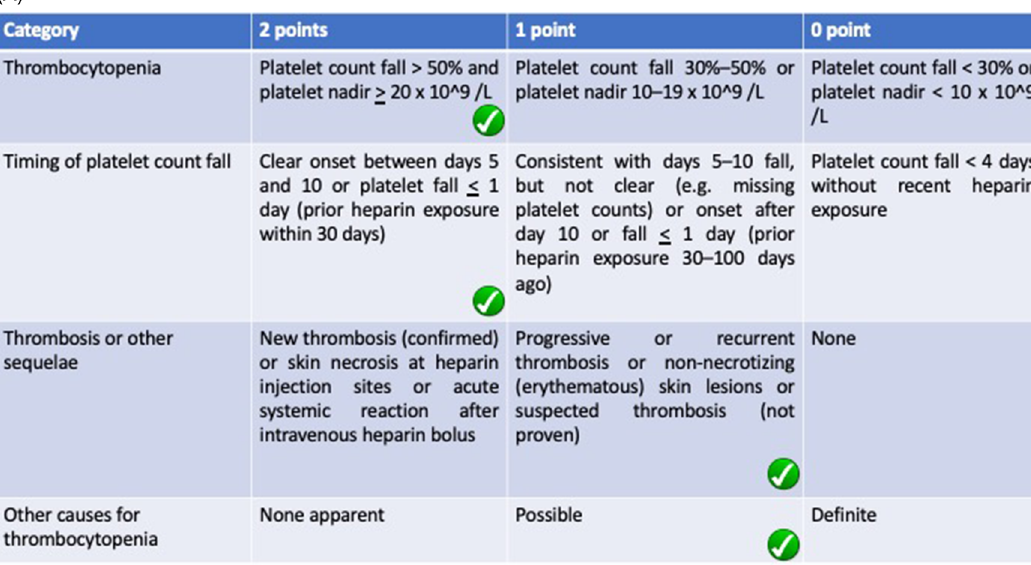
Figure 2. Checklist of scoring system used in measuring HIT probability using (A) 4Ts scoring system showing 6 point and (B) HEP scoring system showing 5 point. Both measurements show high probability of HIT in this patient.